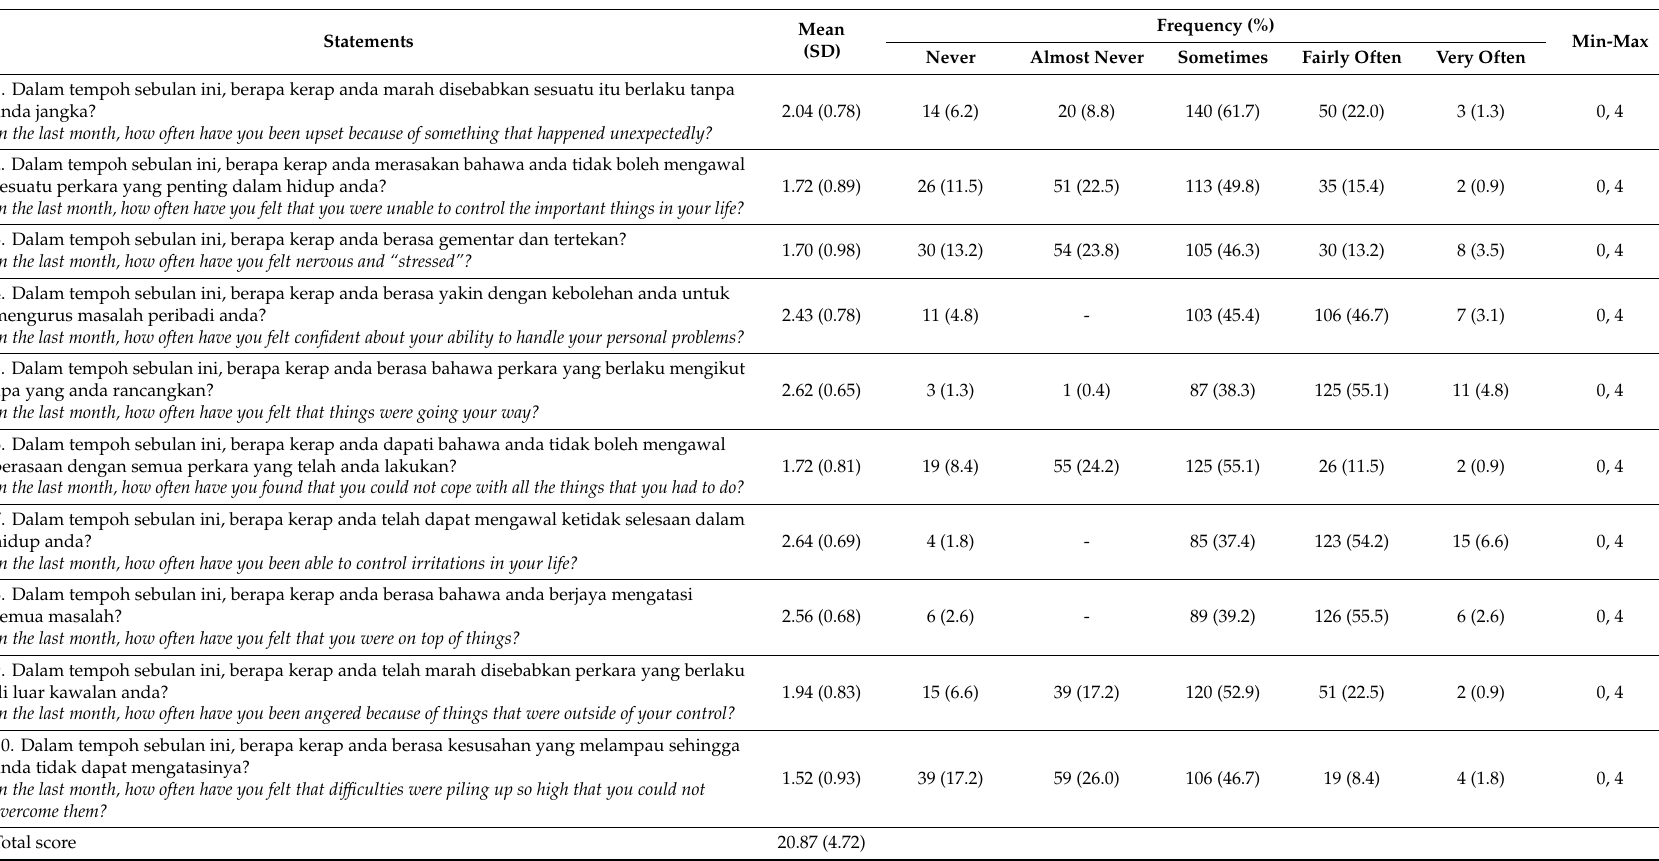
Table 3. The mean and distribution of responses for each question in the Malay version of Perceived Stress Scale-10 Items (PSS-10) ( n =